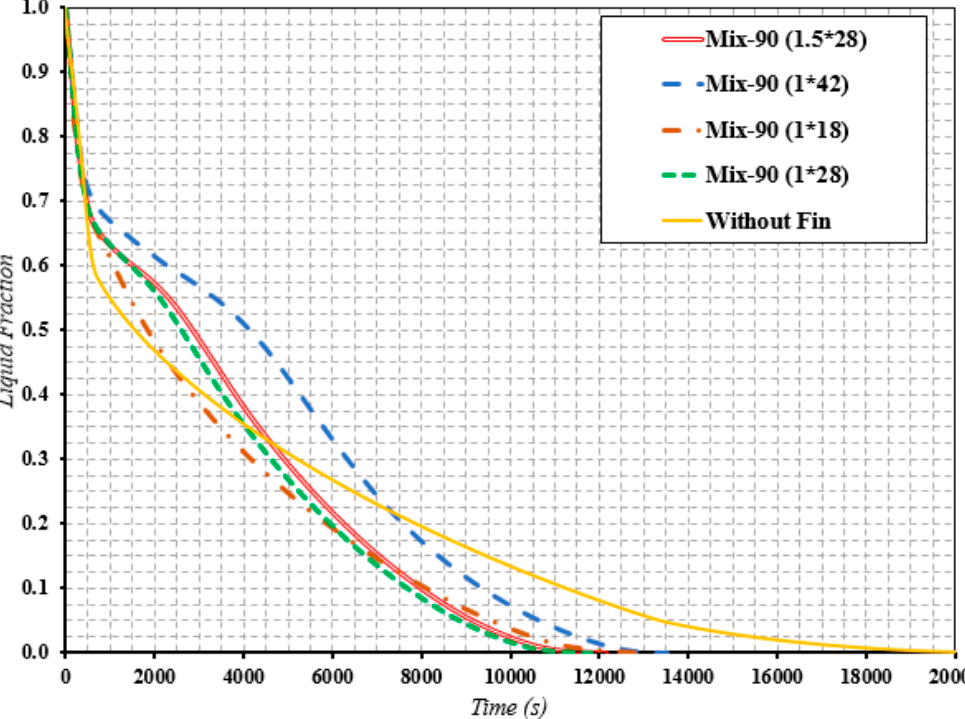
Figure 9. The average liquid fraction during the time for the PCM area with different fins’ dimensions.